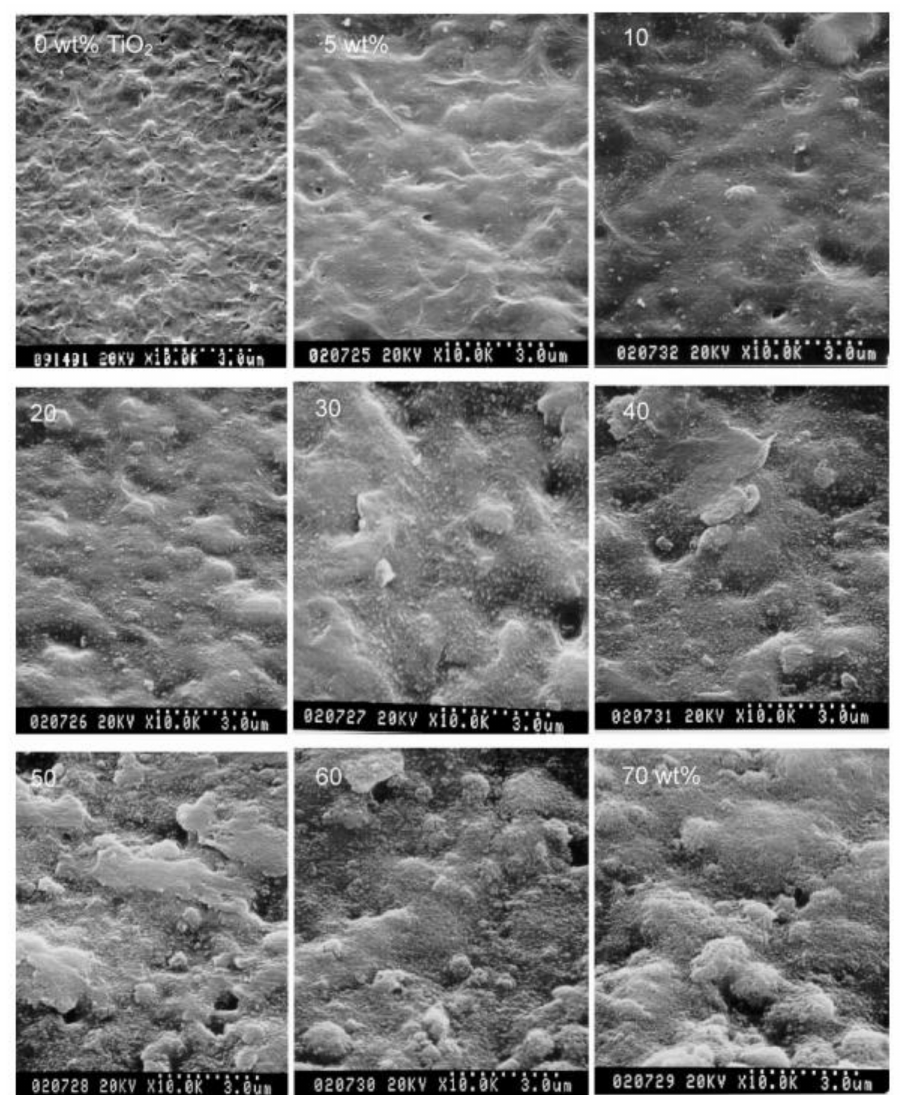
Figure 4. Surface morphology of P poly(vinylidene fluoride-co-hexafluoropropylene) (PVDF-HFP) with varying TiO 2 (rutile) contents from the upper left to the lower right panel. Reprinted with permission from Kim et al. [74]. Copyright 2003 Elsevier